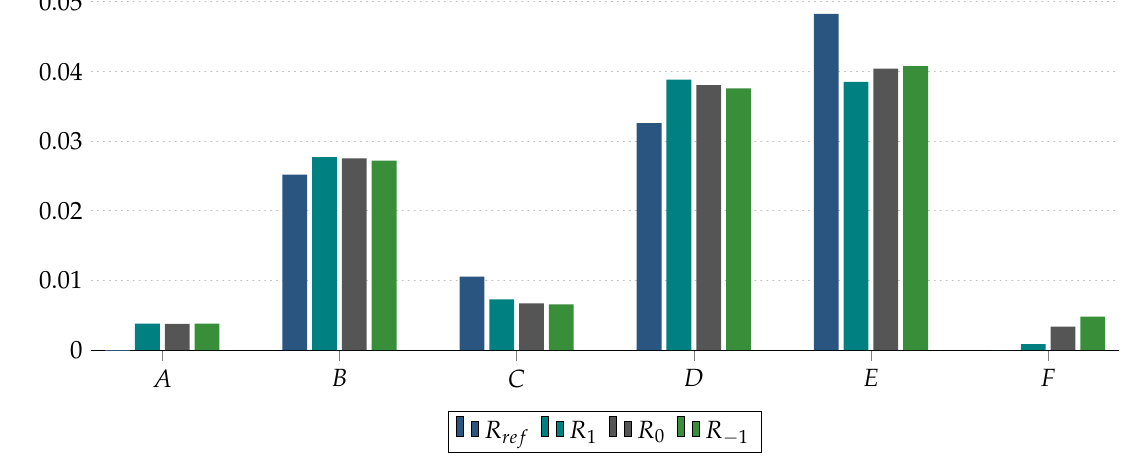
Figure 8. Denton losses ( A – D ), overall mixed-out losses ( E ) and wake distortion losses ( F